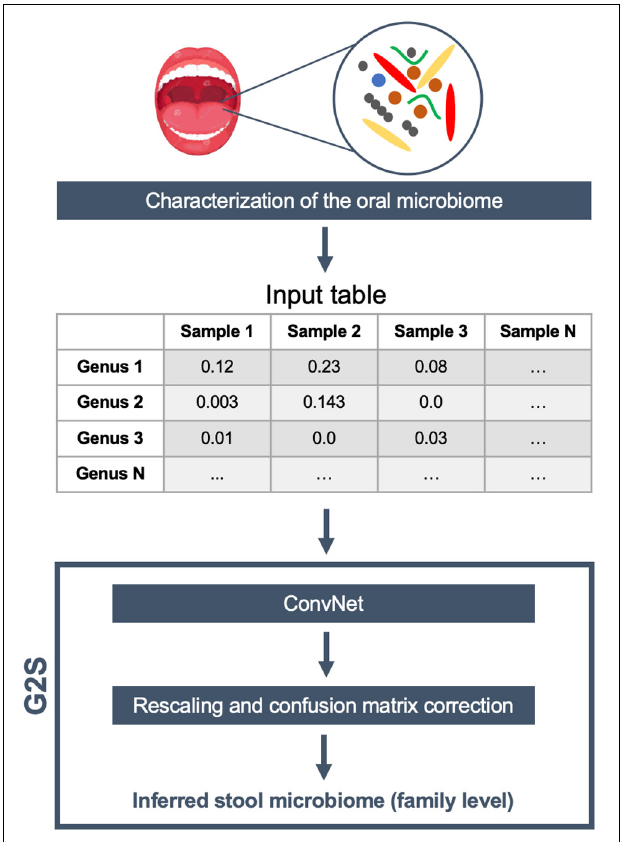
FIGURE 1 | G2S workflow. The input file is a genus-level relative abundance table (.tsv format), obtained from the characterization of human oral microbiome samples. The stool microbiome is inferred using a deep convolutional neural network (ConvNet) adjusted by a confusion matrix and rescaled to 100%. The results are tabulated as relative